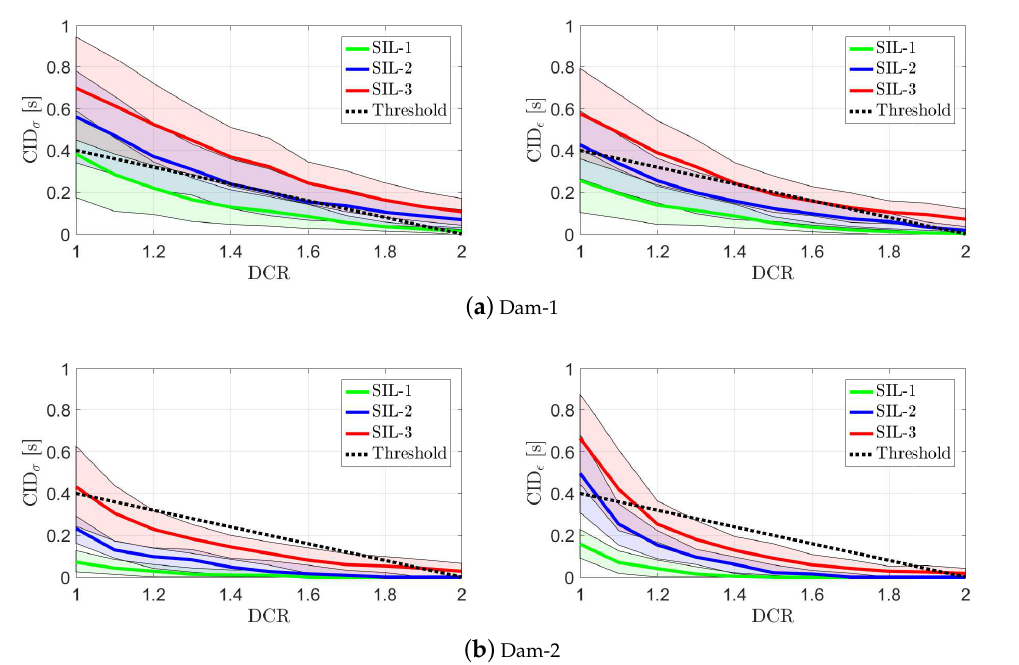
Figure 5. ( a , b ) Cumulative Inelastic Duration–Demand Capacity Ratio (CID–DCR) of arch dams subjected to three seismic intensity